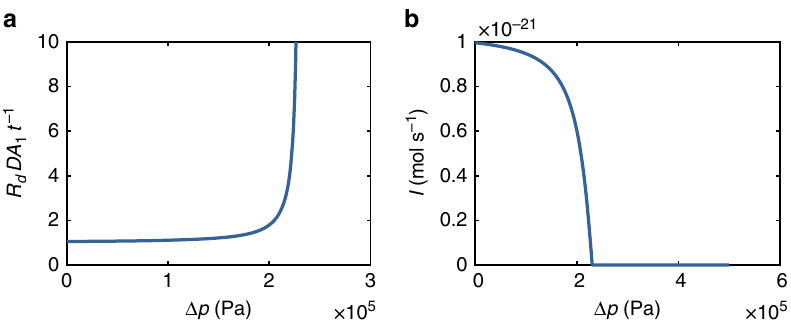
Fig. 3 The impact of pressure on PD resistance and transport. a Normalized diffusion resistance R d DA 1 t − 1 (Eq. (3)) plotted as a function of turgor pressure difference Δ p . b Diffusion current I = Δ c ( R d ) − 1 plotted as a function of turgor pressure difference Δ p for a concentration difference Δ c = 10 μ M.